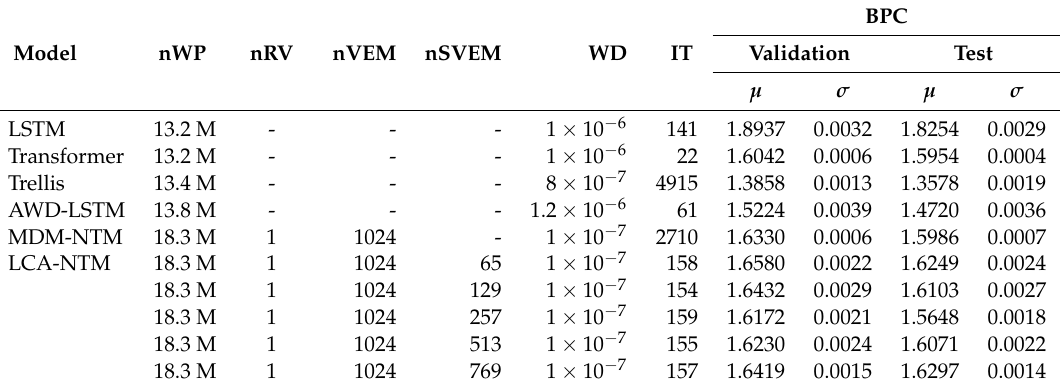
Table 2. Evaluation results of LCA-NTM-based LM according to number of selected memory addresses on the PTB LM task (nWP, number of weight parameters; nRV, number of read vectors; nVEM, number of vectors in the external memory; nSVEM, number of selected vectors in the external memory; WD, weight decay; IT, inference time (ms/batch); µ , mean of BPC results; σ , standard deviation of BPC